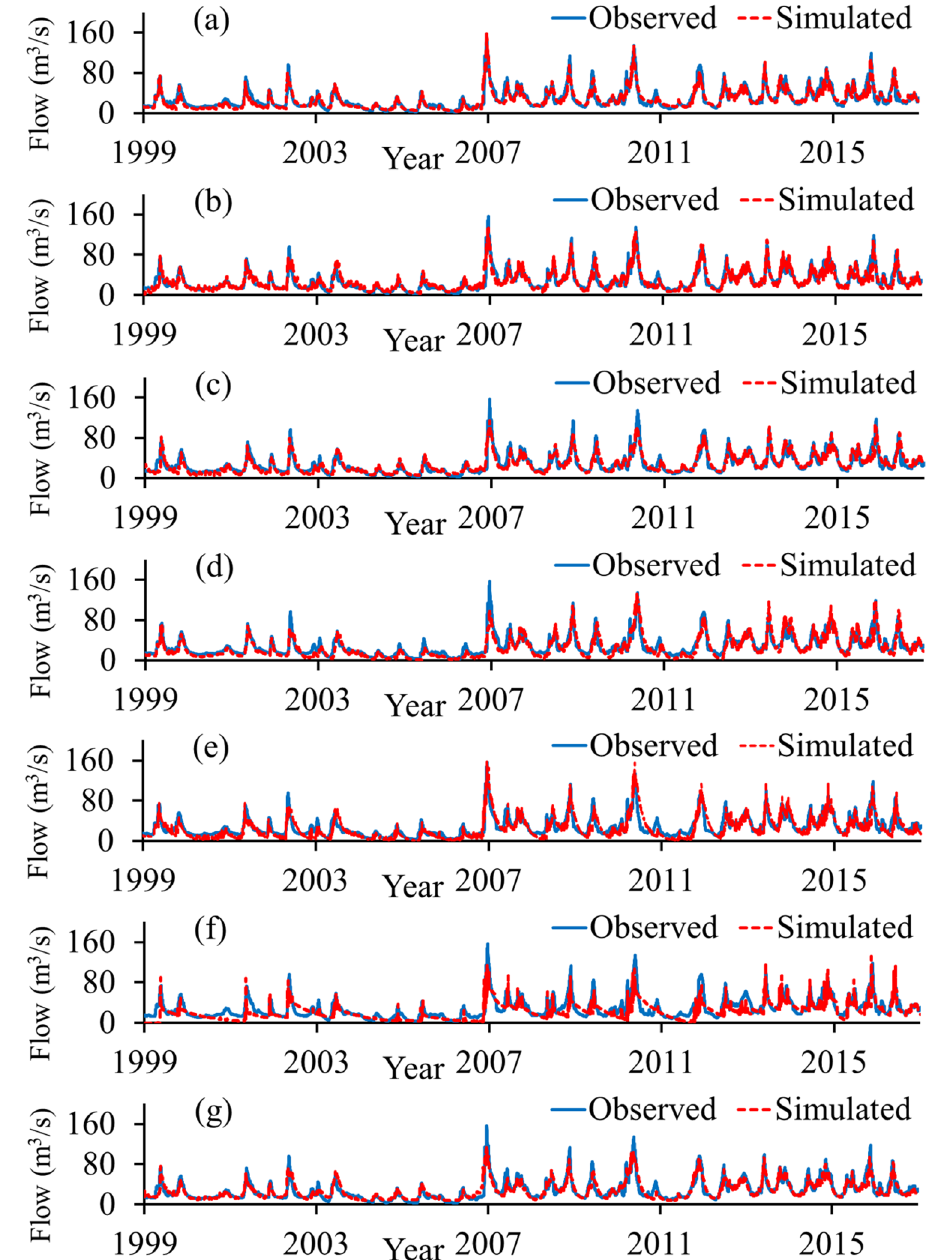
Fig. 3 Observed discharge and simulated flows using a